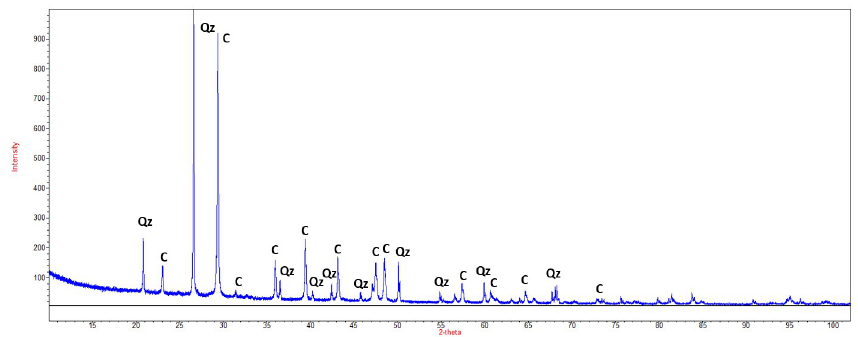
Fig 2. XRD analysis of the wall vertical surfaces. C is for calcite (00-900-9666) and Qz for quartz (00-900-0095) from COD 1906